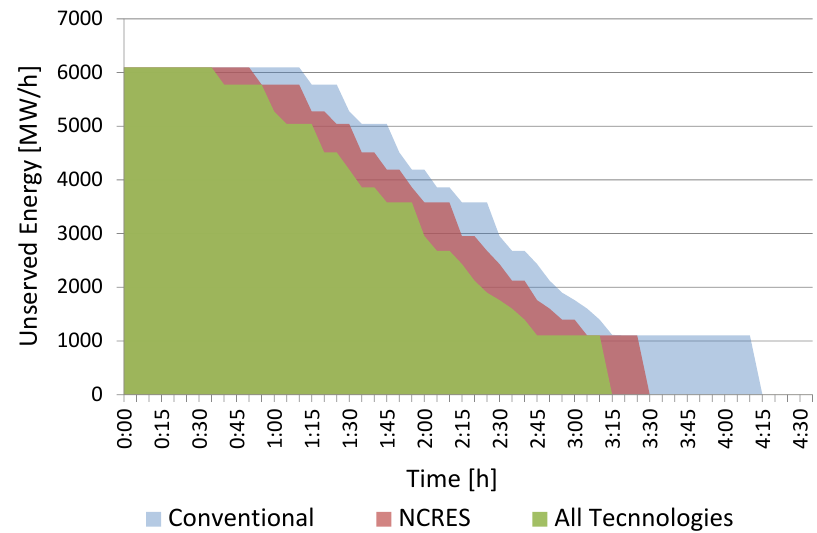
Figure 9. Unserved energy for different scenarios.